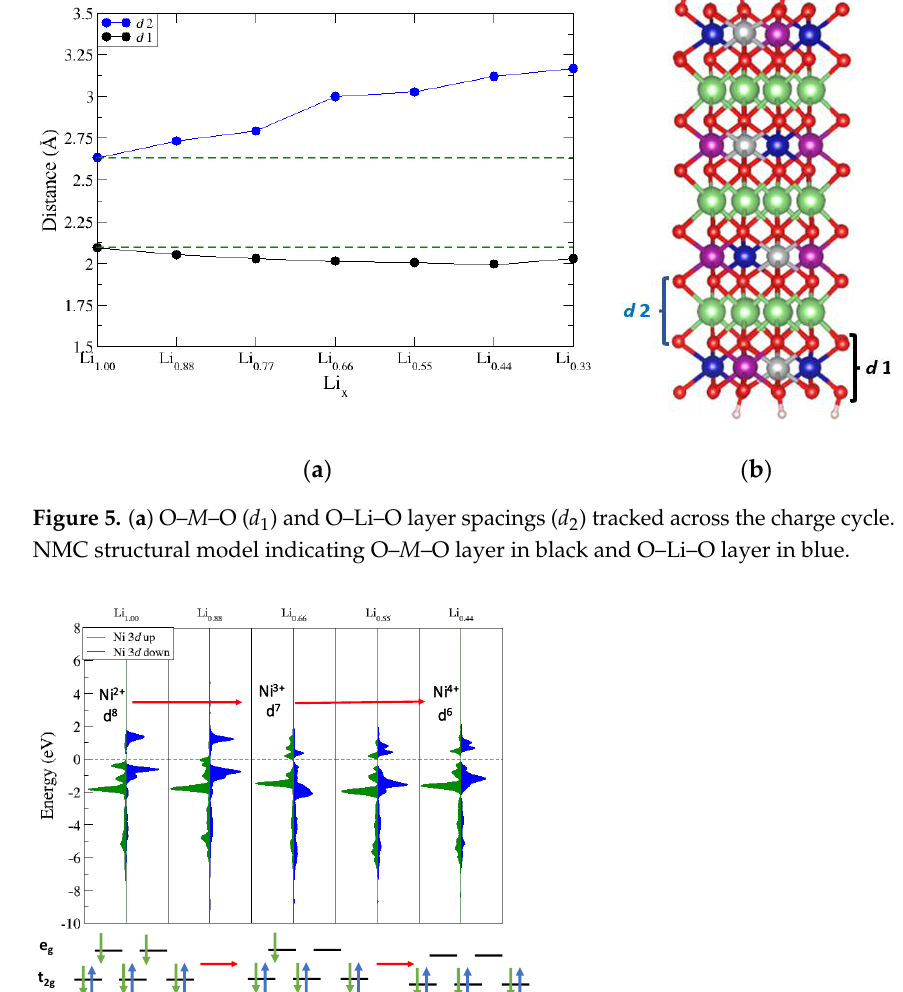
Figure 6. Projected densities of states of surface Ni d-states as a function of Li x with down-spin density in green and up-spin in blue. E F is set to zero, indicated by the dashed purple line. Electron field splits are provided below to show the changes in Ni oxidation state.